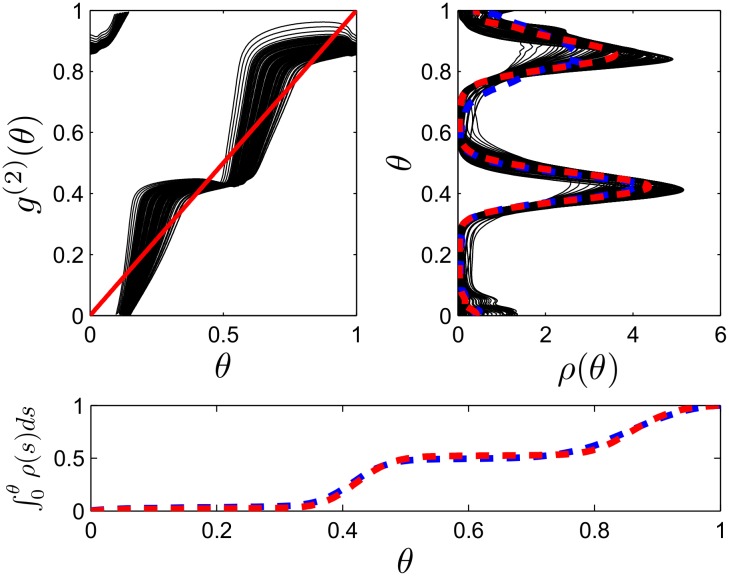
Heterogeneous pulsatile inputs.The top-left panel shows g
(2)(θ) (black lines) for DBS input at 140 Hz at multiple stimulation strengths with the identity line plotted in red for reference. The top-right panel shows the associated theoretical steady state probability distributions (black lines), average theoretical probability distribution (dashed red line), and computationally observed probability distributions (dashed blue line). The bottom panel shows the cumulative distributions for the average theoretical (red line) and computational (blue line) distributions.